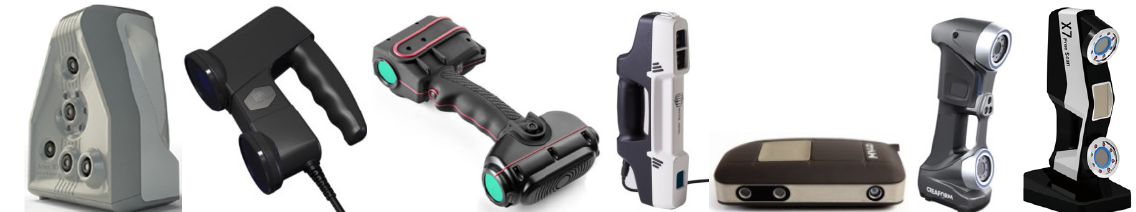
Figure 1. Hand-held 3D scanning systems tested (f.l.t.r.) - Artec Spider, Mantis F5-SR, Mantis F5-B, Mantis F6 SMART, Mantis